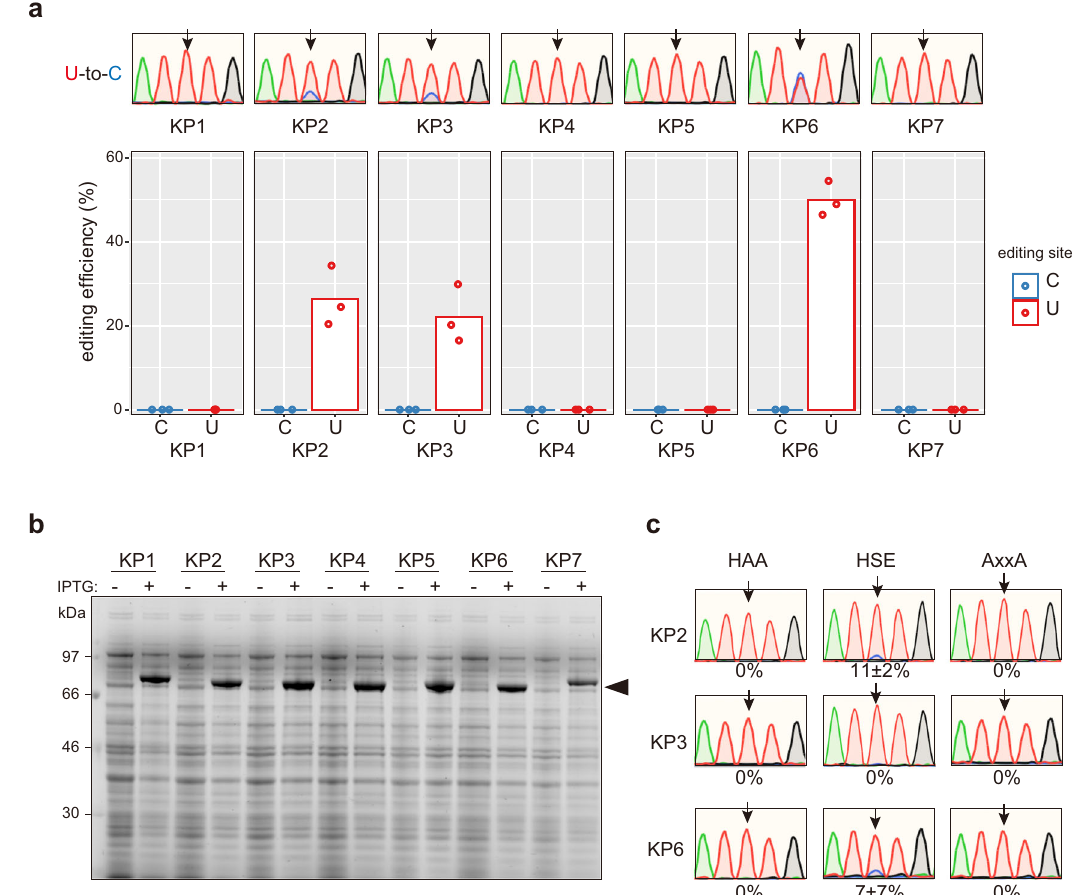
Fig. 3 RNA editing activity of DYW:KP proteins in bacteria. a The DYW:KP proteins exhibit U-to-C editing activity in bacteria. The sequence chromatogram corresponds to the cDNA sequence of the U-to-C editing sites. Arrows indicate the editing site. The editing ef fi ciency is given as the mean of three biologically independent replicates. Each dot corresponds to one replicate. b The expression of the PPR proteins were veri fi ed on a denaturing sodium dodecyl sulfate-polyacrylamide gel electrophoresis (SDS-PAGE) gel after loading bacterial lysates before ( − ) and after ( + ) 18 h IPTG induction. Arrowhead indicates the predicted molecular weight of the DYW:KP proteins. c U-to-C editing relies on the DYW:KP domain. The editing ef fi ciency of DYW:KP mutants is given as the mean ± s.d. of three biologically independent